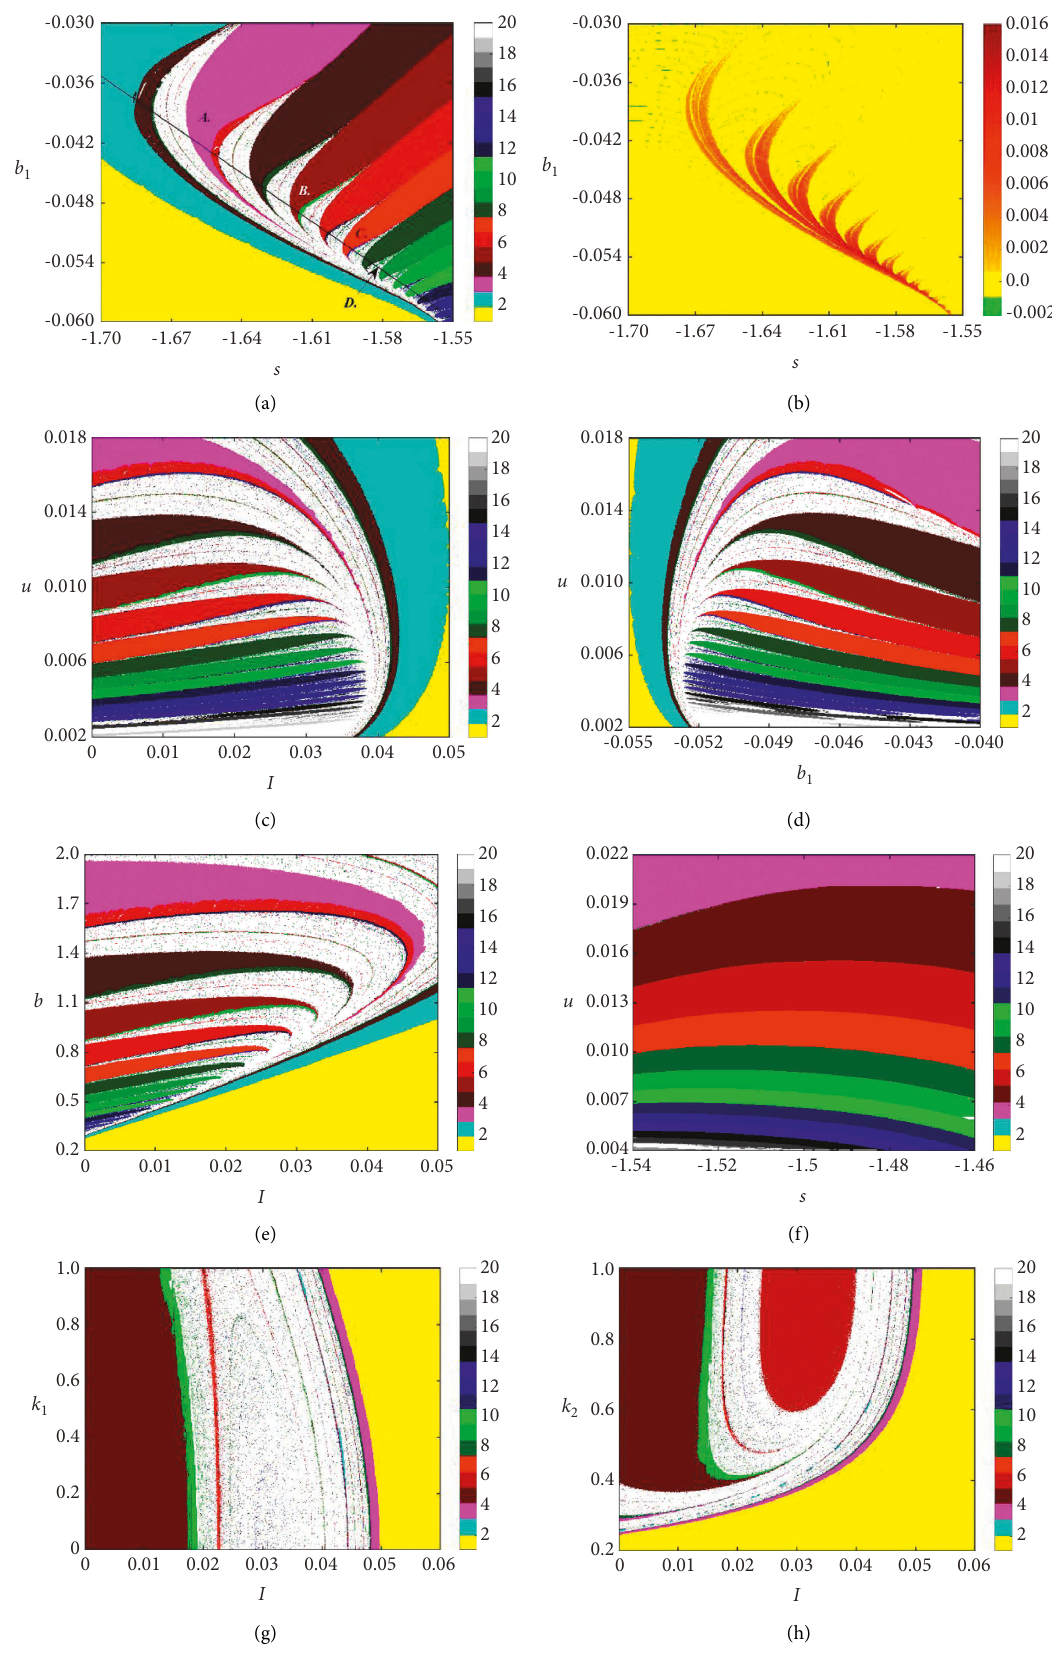
Figure 2: Dynamic details of system (1) for different parameter combinations: (a) s ∈ [− 1 . 70 , − 1 . 55 ] , b exponent of (a); (c) I ∈ [ 0 , 0 . 05 ] , u ∈ [ 0 . 002 , 0 . 018 ] ; (d) b s ∈ [− 1 . 54 , − 1 . 46 ] , u ∈ [ 0 . 004 , 0 . 022 ] ; (g) I ∈ [ 0 , 0 . 06 ] , k